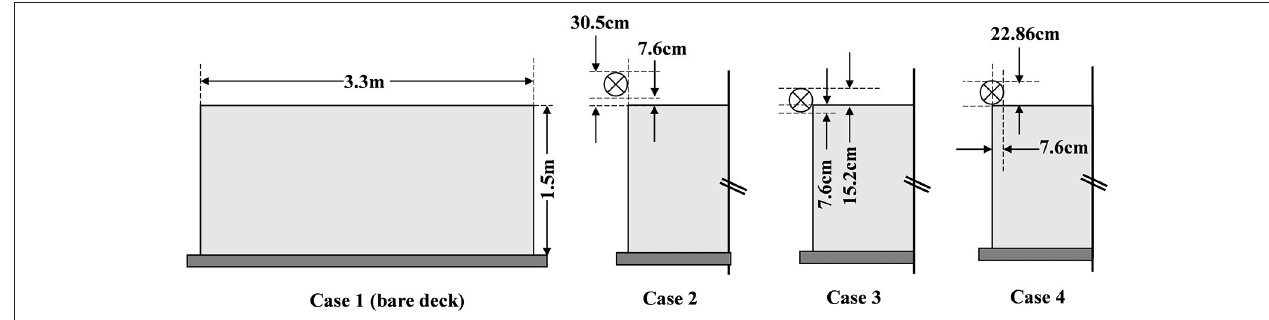
FIGURE 4 | Schematic of the different cases tested in the WOW (note: the turbine location with respect to the building is shown in each case).